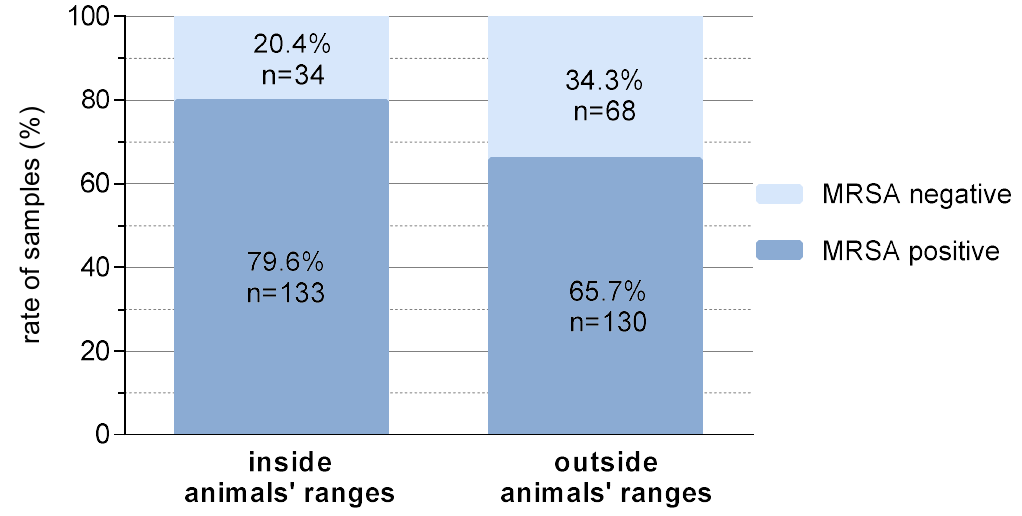
Figure 1. Prevalence of livestock-associated methicillin-resistant Staphylococcus aureus (LA-MRSA) before cleaning and disinfection (C&D) inside and outside animals’ ranges.